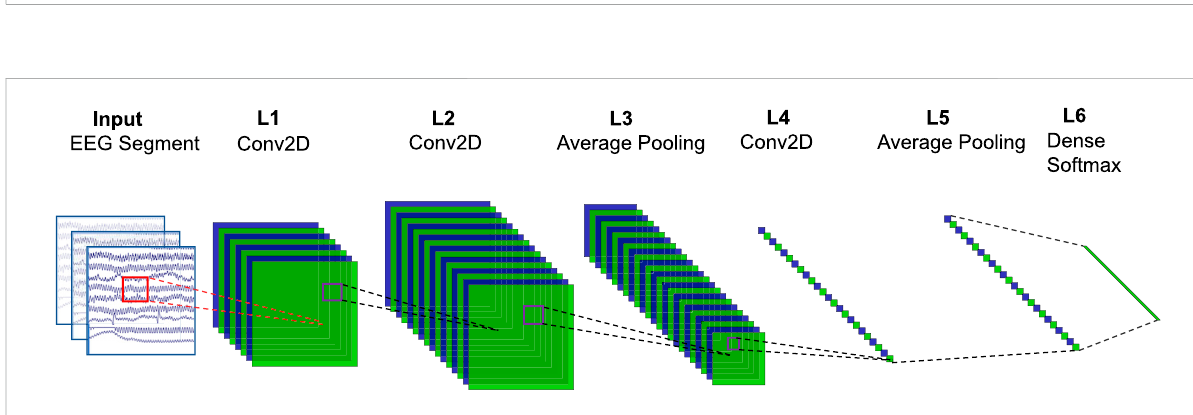
FIGURE 2 Network structure. The input is a multi-channel EEG segment with a dimension of 16 ( channel ) × 5000 ( sampling point , 5 × 1,000). L1 is a temporal fi lter that contains 8 fi lters with a1 × 32kernel. L2is aspatial fi lter that contains 16 fi lterswith a16 × 1 kernel. InL3, thepool size is(1, 3), and thestrideisnone.L4contains16 fi